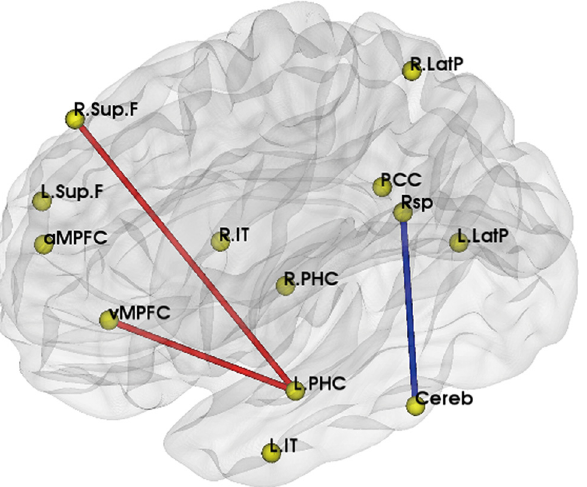
carriers, and blue line represented the decreased one.